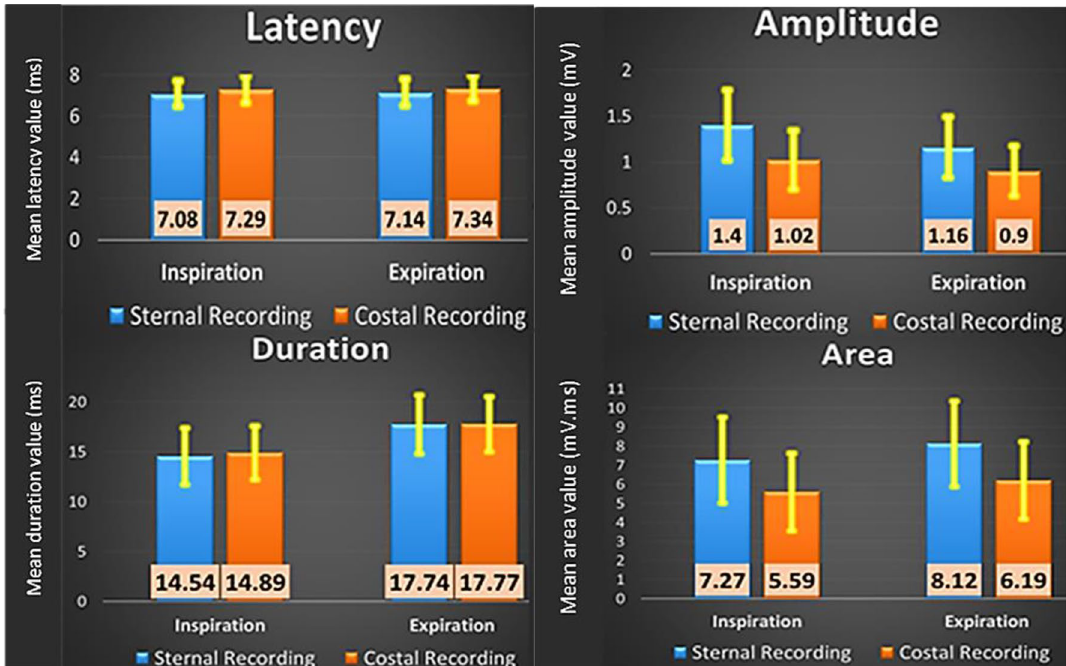
Figure 2. Mean values of sternal and LCW DCMAPs parameters during inspiration and